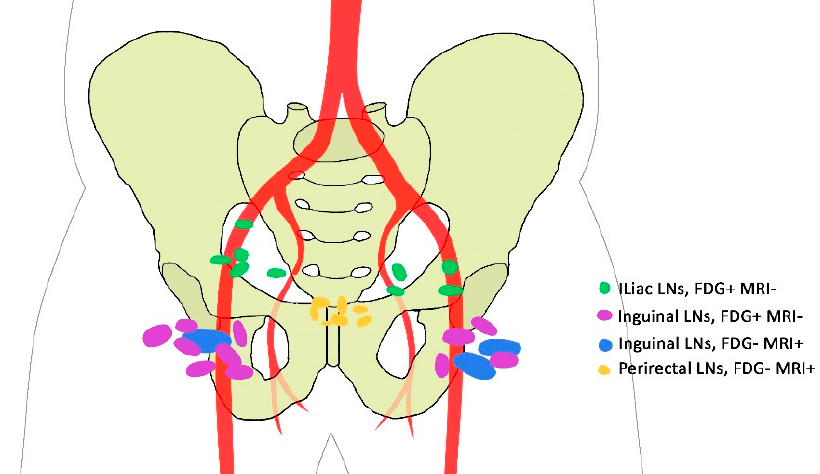
Figure 2. Discrepancy between 2-[ 18 F]FDG PET / CT and MRI regarding regions of involved lymph nodes. LN: Lymph Node; FDG: 2-[ 18 F]FDG PET / CT; MRI: Magnetic Resonance Imaging; -: negative for metastasis; + : positive for metastasis.